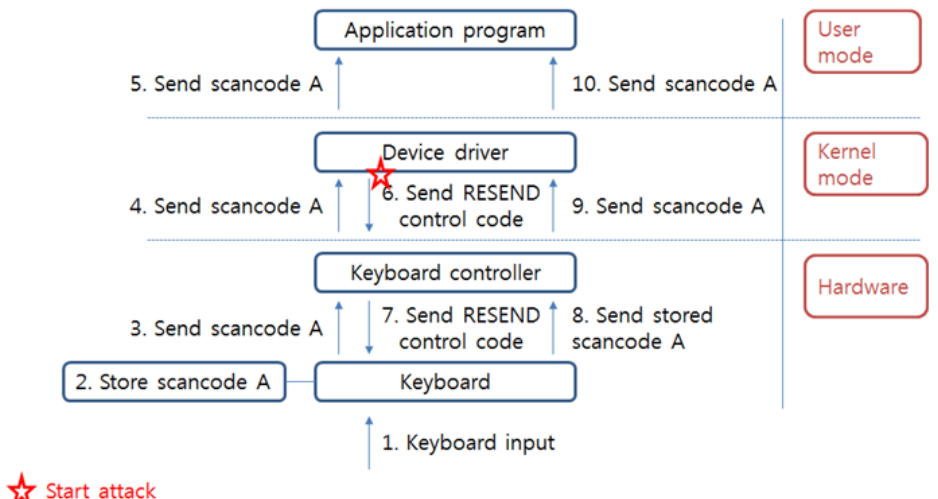
Figure 13. Attack process whereby the RESEND control code is